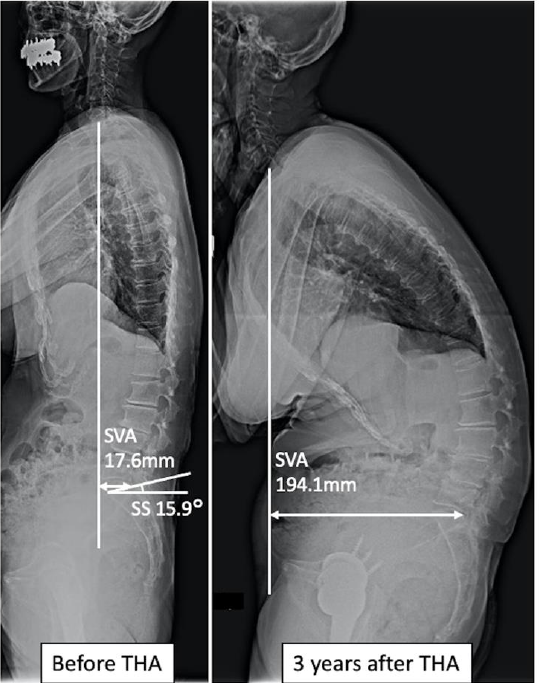
Figure 5. A case of progressive spinal sagittal imbalance after total hip arthroplasty. Preoperatively, the sacral slope, sagittal vertical axis (SVA), and abdominal trunk muscle strength were 15.9°, 17.6 mm, and 3.2 kPa, respectively. Postoperatively, SVA increased to 194.1 mm.